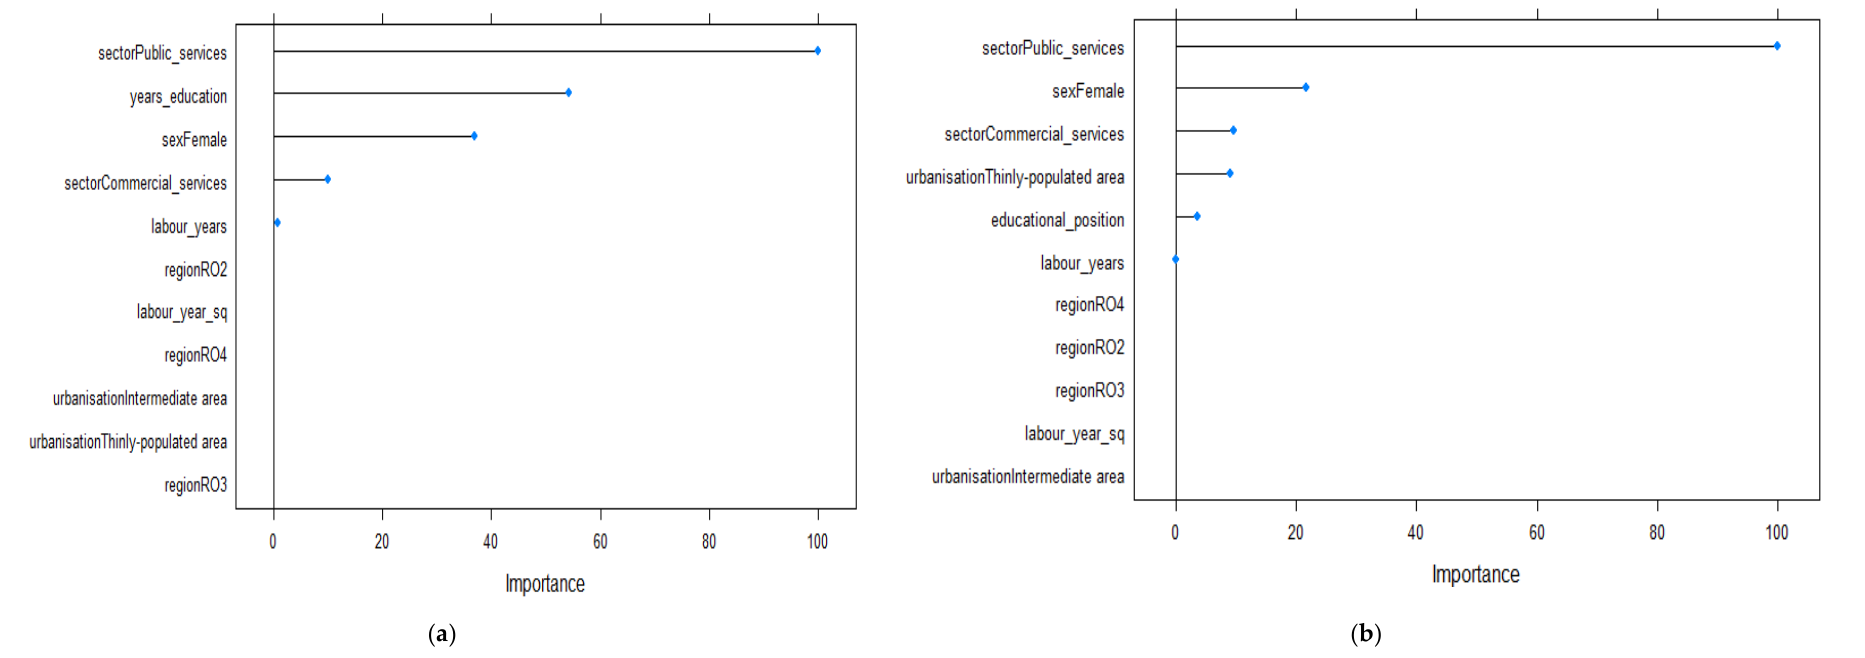
Figure 6. Relevant variables in explaining the variations in wages based on the Enet method for the 55 – 64 year old age group ( n = 868): ( a ) model 1 using the absolute measure of education; ( b ) model 2 using the relative measure of education.